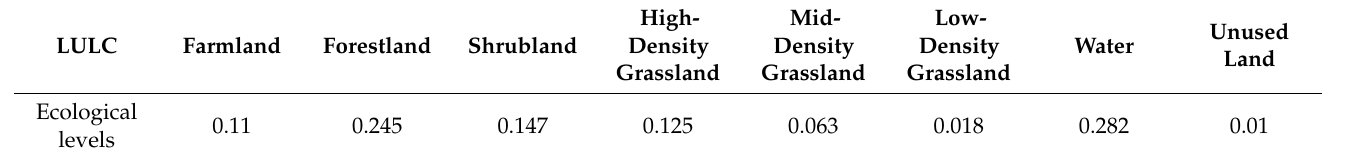
Table 1. Ecological levels of the different land use